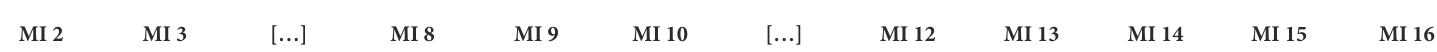
TABLE 8 Correlations of LPM sum